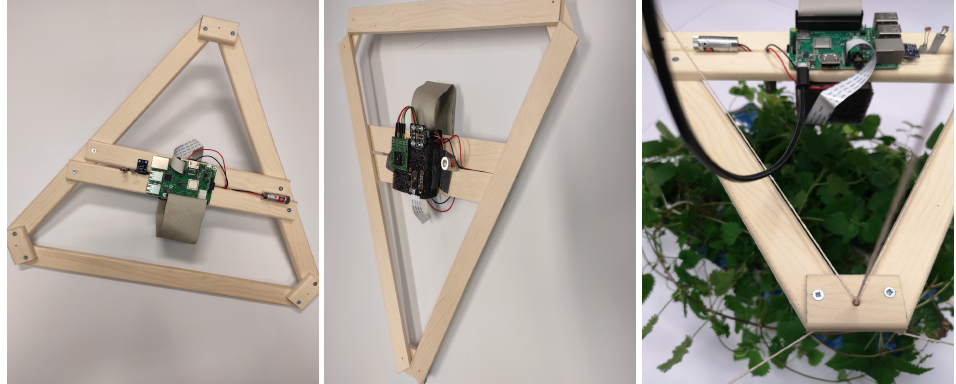
Figure 5. Suspended platform model. View from above and below on mounted internal sensor node. Suspended platform model during experimental positioning—test of cameras and platform stability during image